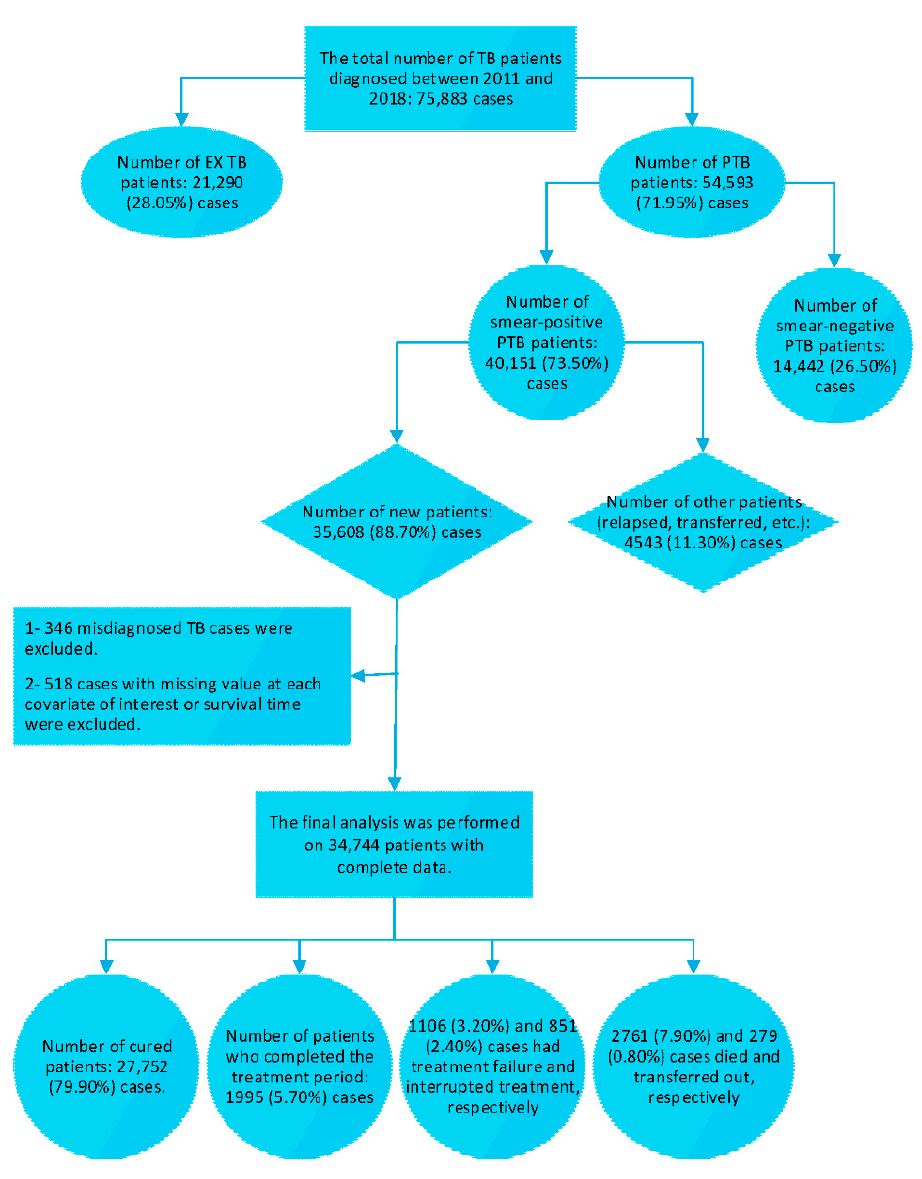
Figure 1. Study population. Treatment outcomes for new smear-positive PTB patients were defined according to WHO guideline [42].